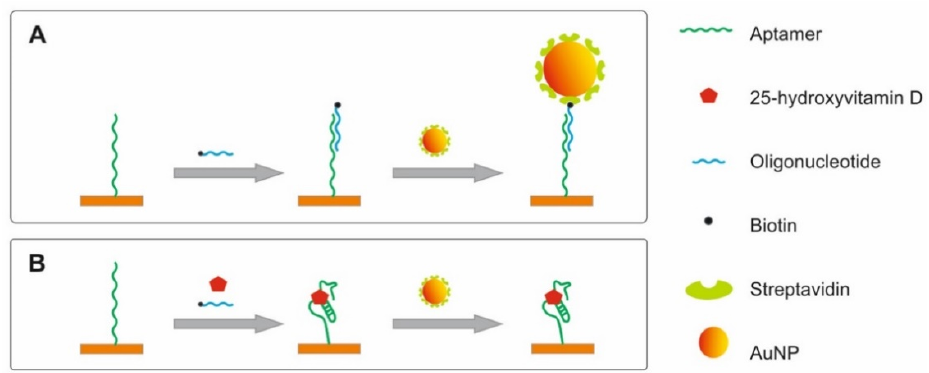
Figure 5. Schematic of the sensing strategy; Aptamers directed against 25-hydroxyvitamin D are immobilised on the sensor surface. In the absence of vitamin D, the aptamers hybridize with the complementary oligonucleotide. As the complementary oligonucleotide is biotinylated, it can bind streptavidin-modified AuNPs for signal enhancement ( A ). Aptamers that are bound to 25-hydroxyvitamin D do not facilitate hybridization of complementary oligonucleotide and binding of AuNPs ( B ).